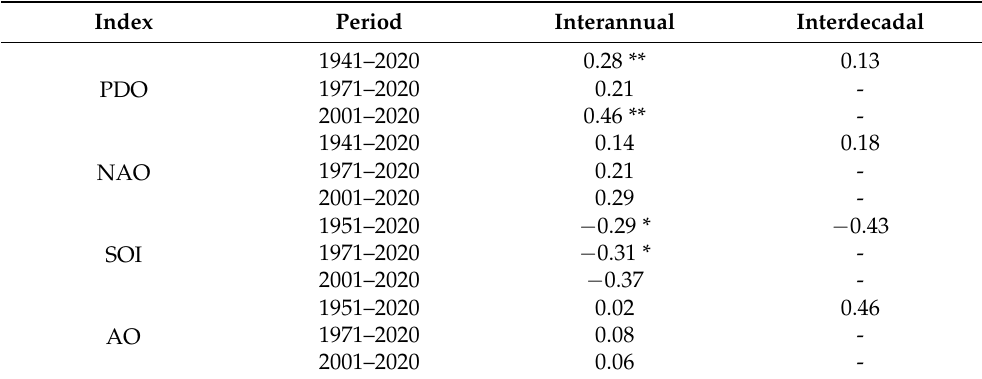
Table 2. PCC between four ocean oscillation indexes and precipitation in the Pan-Central-Asia arid region.